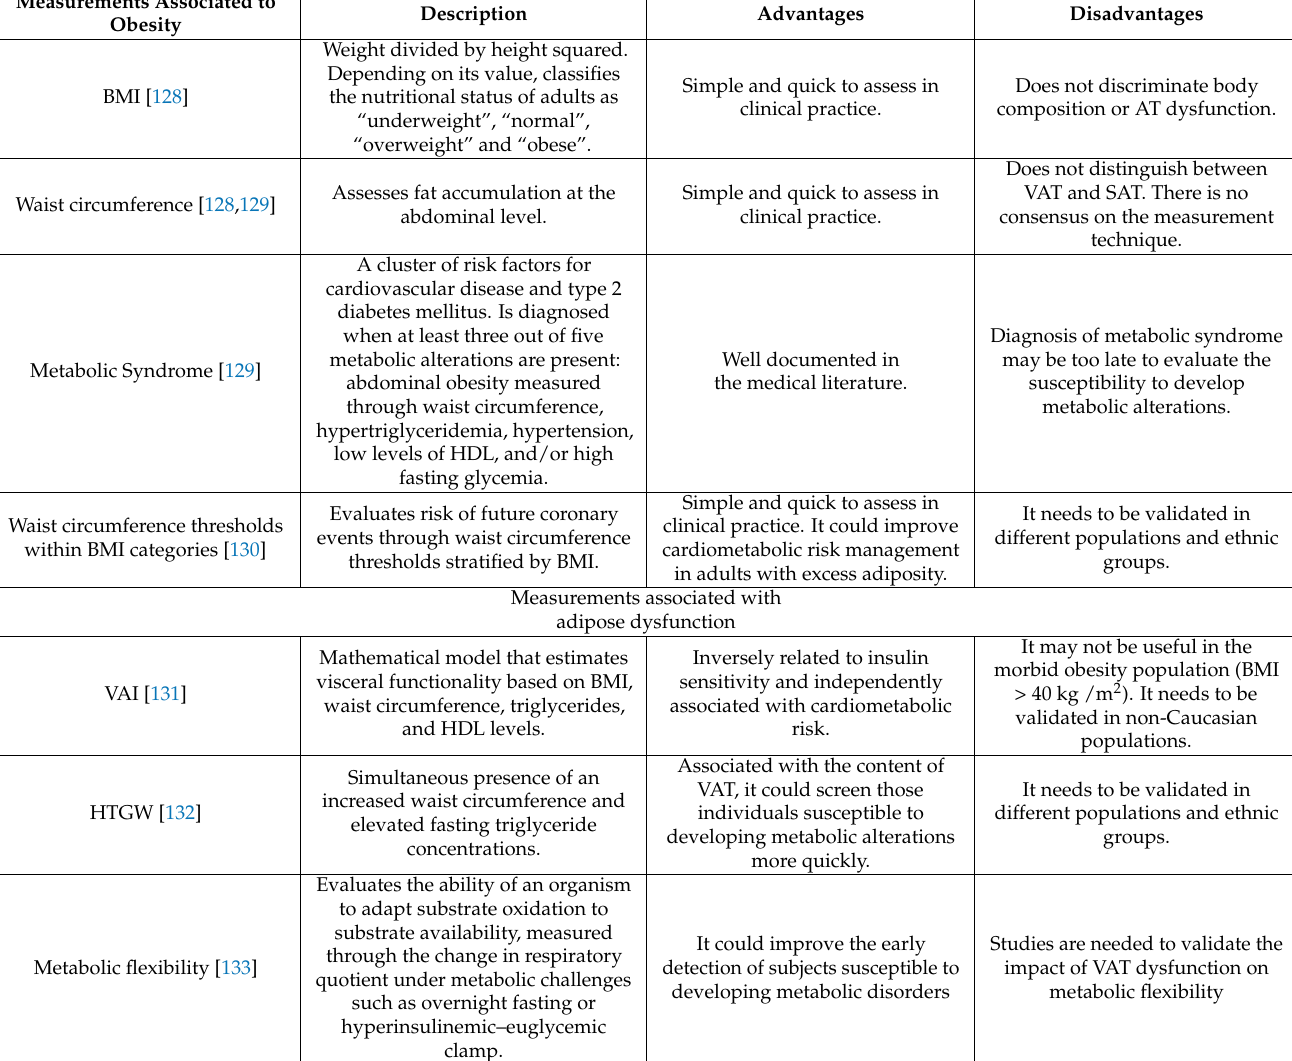
Table 1. Measurements associated with obesity and adipose